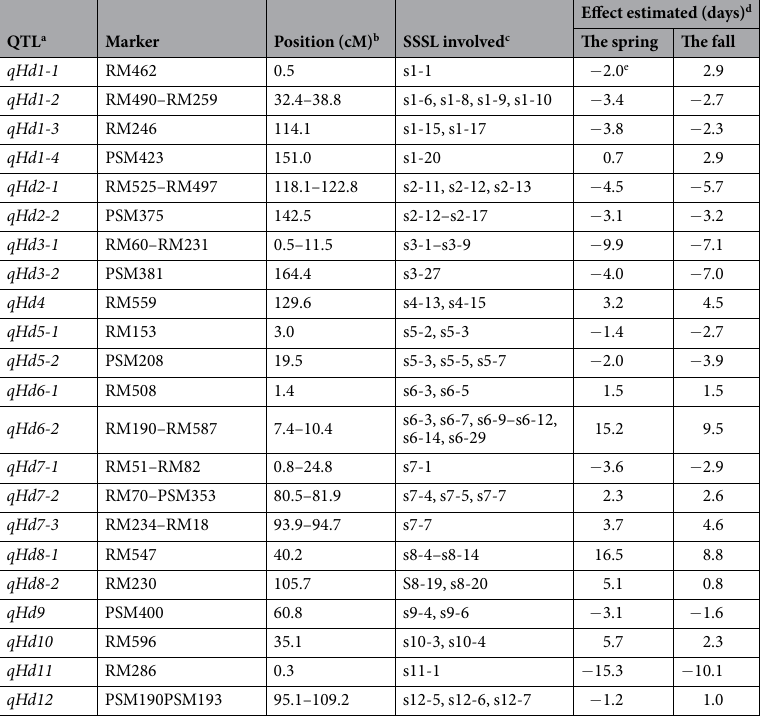
Table 3. QTL effects estimated by averaging over effects of participation single segment substitution lines (SSSLs) on heading date (HD) in the spring and the fall. a QTL was nominated by qHd followed chromosomal number or -serial number. b Position (cM) indicated the positions of QTL on chromosomes. c si-j represented jth SSSL on chromosome i . d QTL effects were showed by the effects estimated by averaging over SSSLs involved. e The negative sign in the table indicated to shorten